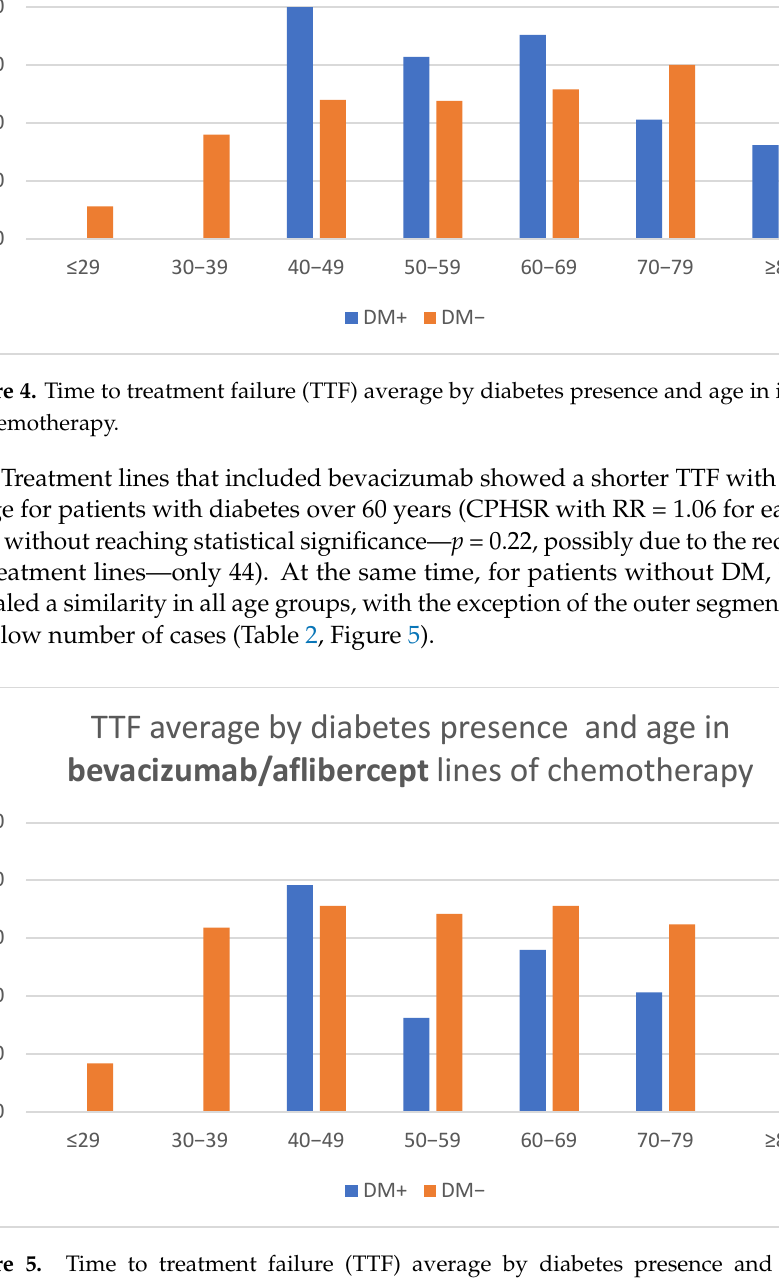
Figure 6. Time to treatment failure (TTF) average by diabetes presence and age in cetuximab/pani- tumumab lines of chemotherapy. Trifluridine/tipiracil were only included in 33 treatment lines, insufficient for the achievement of statistically valid correlations. Analysis of mean TTF values for treatments including fluoropyrimidine, oxaliplatin, or irinotecan did not reveal statistically signifi- cant differences in the t -test (Table 3). It has been found, however, that DM had a